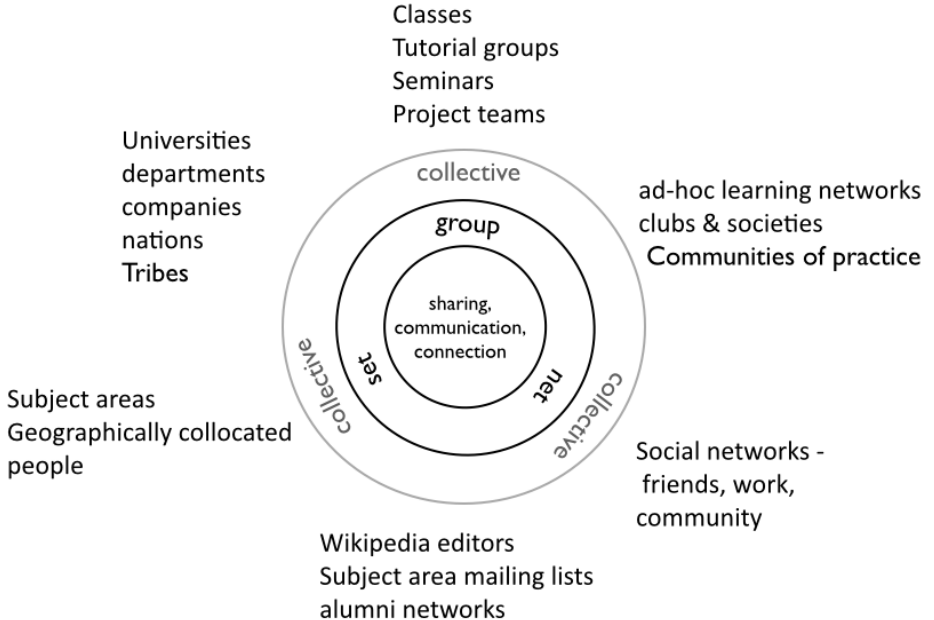
Figure 1. Sets, nets, groups, collectives and some examples of typical forms they